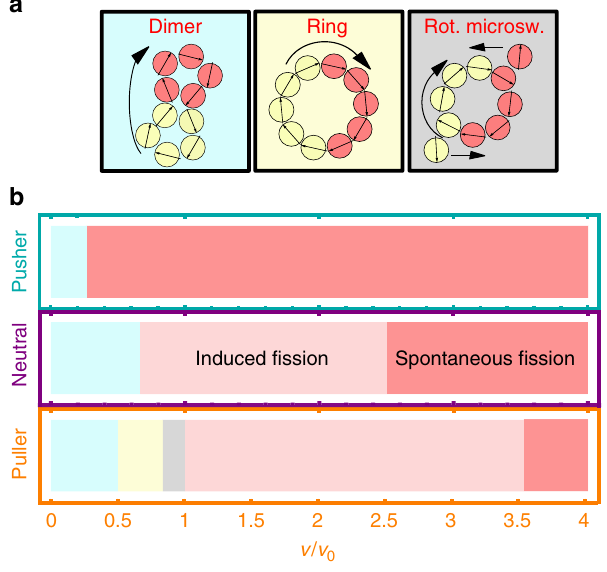
Figure 9 | Spontaneous fusion and fission for ring-like clusters with the same vorticity. ( b ) Emerging states for all the swimmers types as a function of reduced self-propulsion velocity v / v 0 —see Supplementary Movies 4–6. Different states are indicated by different colours and fused states are sketched in panel a and characterized as: (i) a spontaneously fused rotating dimer, (ii) an emerging closed ring of N ¼ 10 swimmers, (iii) a closed ring of N ¼ 8 swimmers with counter rotating microswimmers, (iv) induced fission into various fragments and (v) spontaneous fission of the individual initial ring-like